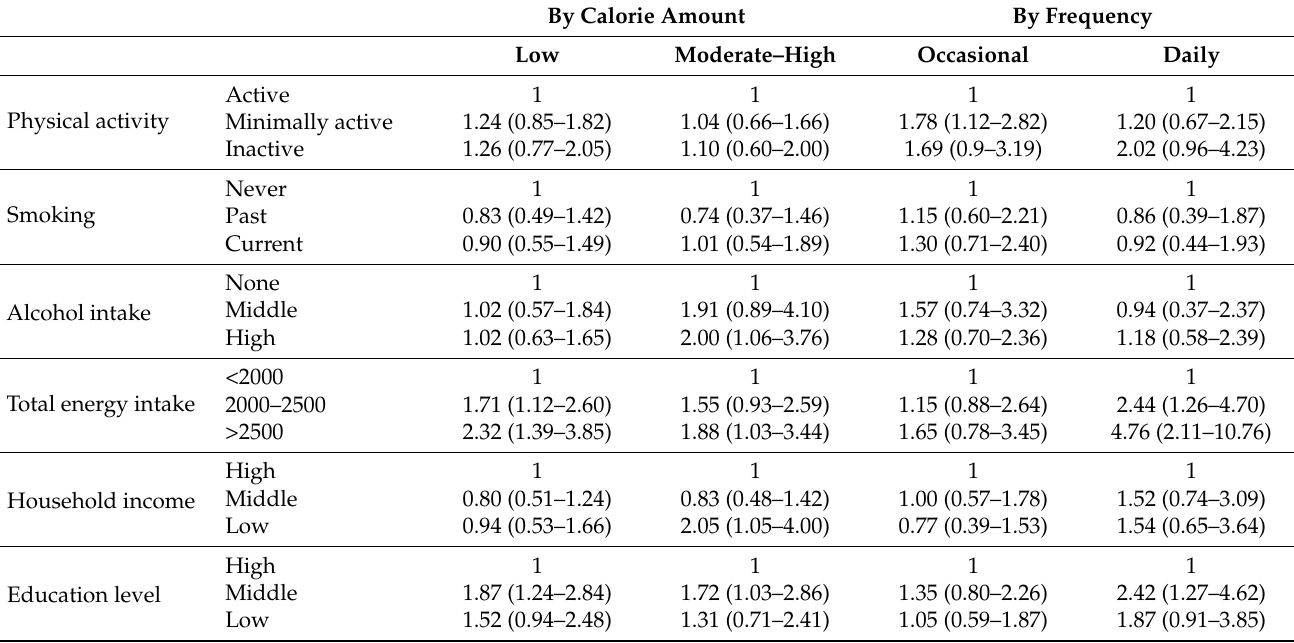
Table 7. Behavioral and social factors related to the different SSBs consumption patterns, fully adjusted using a multinomial regression